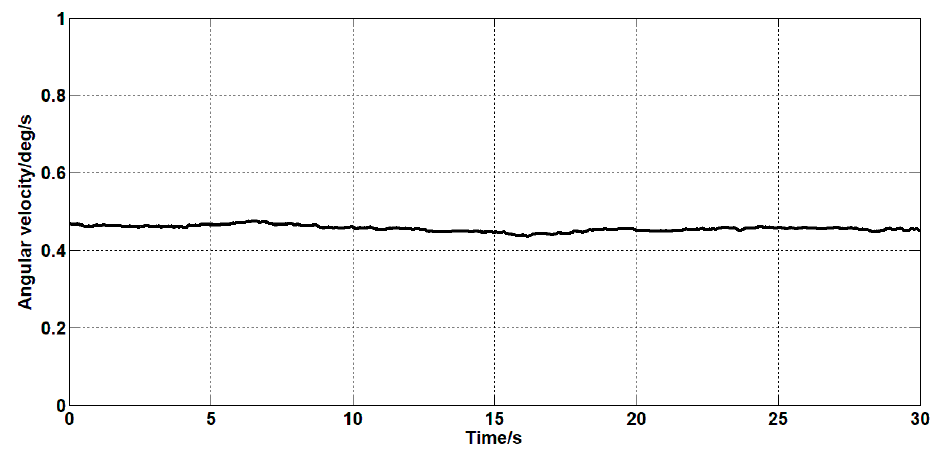
Figure 16. The estimated curve of the drift of the gyroscope.